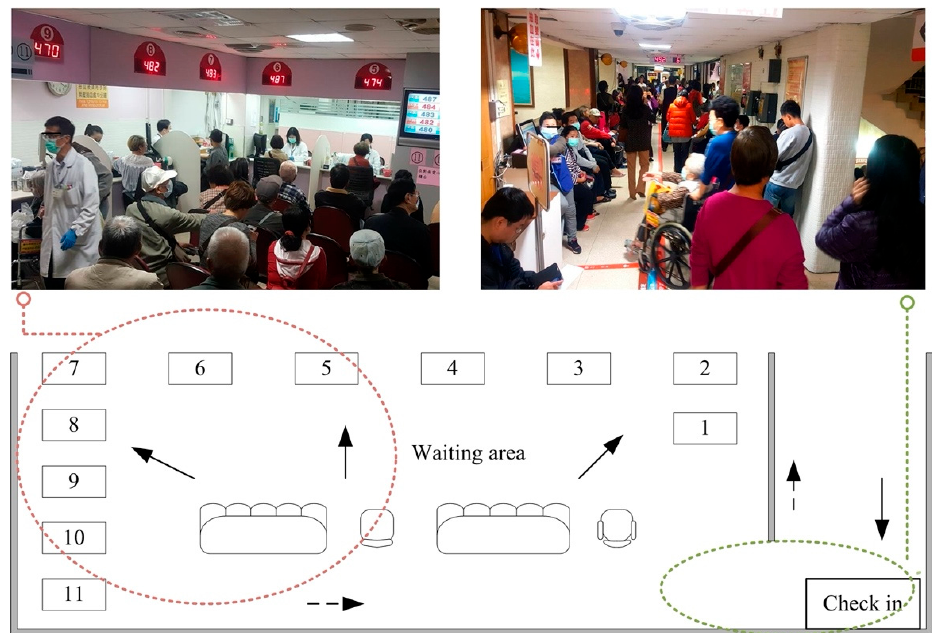
Figure 1. The phlebotomy service area and patient flow. Blood drawing counters 1–9 were for general subjects, and counters 10–11 were for wheelchair users at baseline. The area of the waiting area was about 49.9 m 2 . Solid arrow: the subjects arriving; Dotted arrow: the subjects leaving.